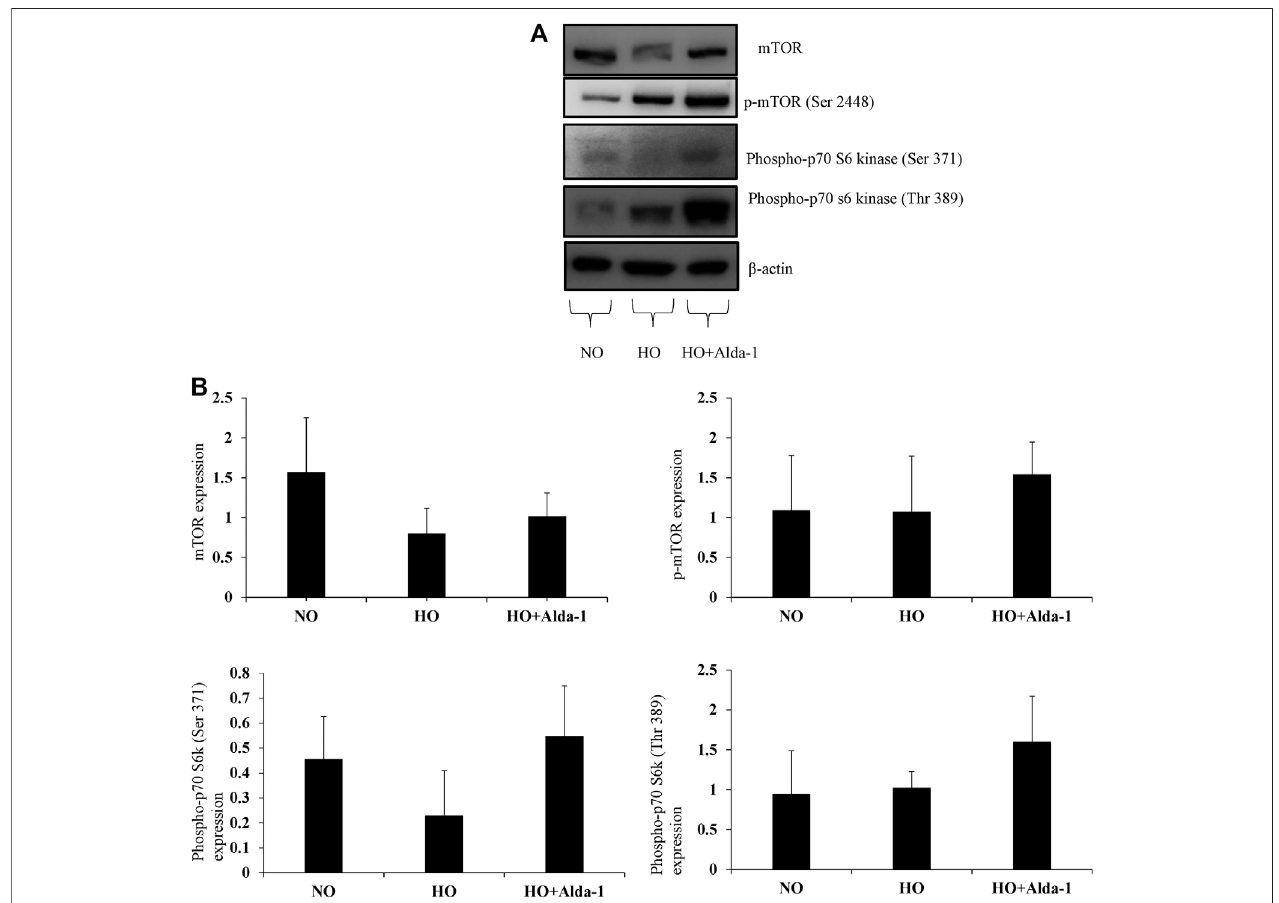
FIGURE 4 | Alda-1 attenuates hyperoxic lung injury via mTOR pathway: Three groups of C57BL/6 mice received exposure to normoxia, hyperoxia, or hyperoxia + Alda-1 for 48 h. Whole cell lysate was collected from lung samples and subjected to western blot analysis for mTOR, p -mTOR (ser 2448), phospho-p70 s60 kinase (ser 371), and phospho-p70 s60 kinase (Thr 389) (A) . β -actin was used as a loading control. Densitometry analysis shows the expression of mTOR, p -mTOR (ser 2448), phospho-p70 s60 kinase (ser 371), phospho-p70 s60 kinase (Thr 389) (B) . Representative blots from at least three